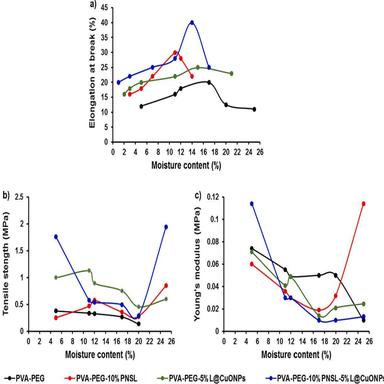
Effect of moisture content on mechanical properties of nanocomposite films (PVA-PEG, PVA-PEG-10%PNSL, PVA-PEG-5%L@CuONPs, and PVA-PEG-10% PNSL-5%L@CuONPs); a) Elongation at break; b) Tensile strength; and c) Young's modulus.